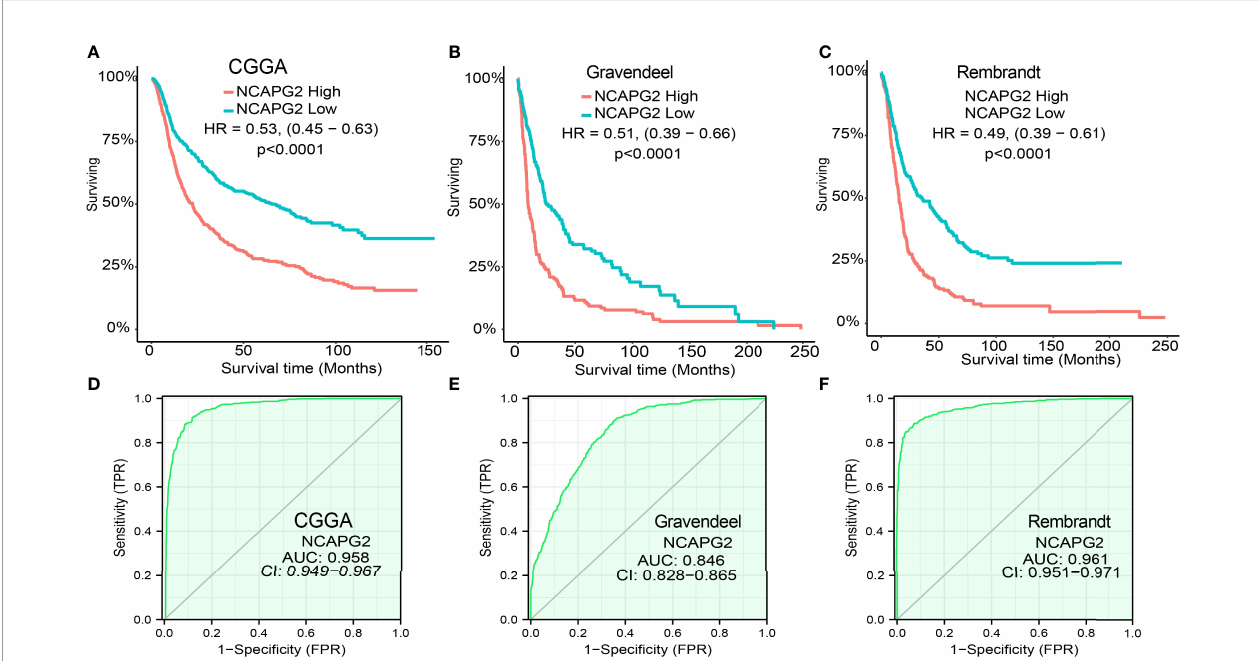
FIGURE 4 | Validation of the prognostic and prognostic value of NCAPG2 in glioma. (A – C) Validation of the prognosis of NCAPG2 in glioma by CGGA, Rembrandt and Gravendeel datasets (D – F) ROC analyses revealed the predictive value of NCAPG2 in glioma based on CGGA, Rembrandt and Gravendeel